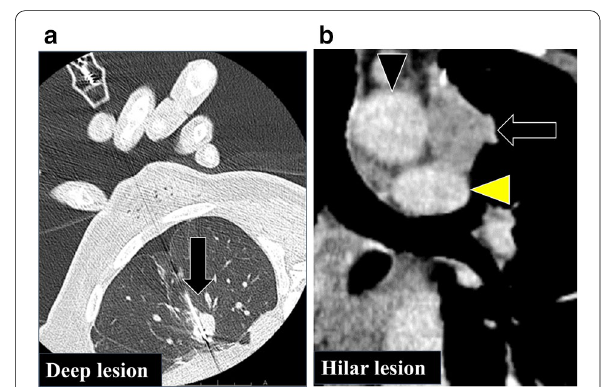
children. Therefore, chemotherapy was not feasible, and PMs were repeated.